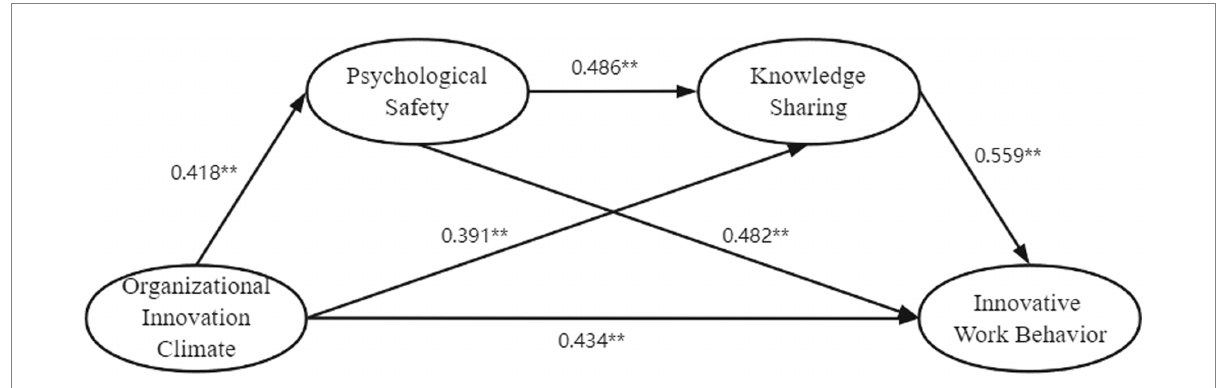
FIGURE 3 The chain mediation model. The chain mediation model shows the effects of organizational innovation climate, psychological safety, and knowledge sharing on innovative work behavior. N = 446. The effect of organizational innovation climate is shown in parentheses. In the PROCESS program of SPSS, the regression coefficient was obtained. ** p < 0.01.